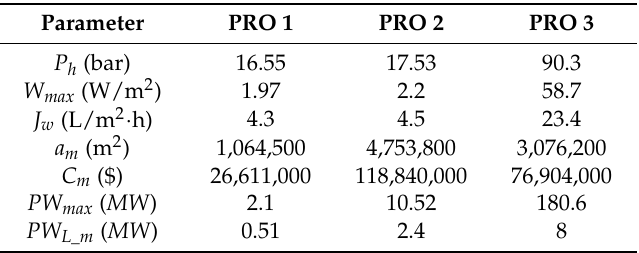
Table 4. Calculated membrane parameters and cost for the three PRO